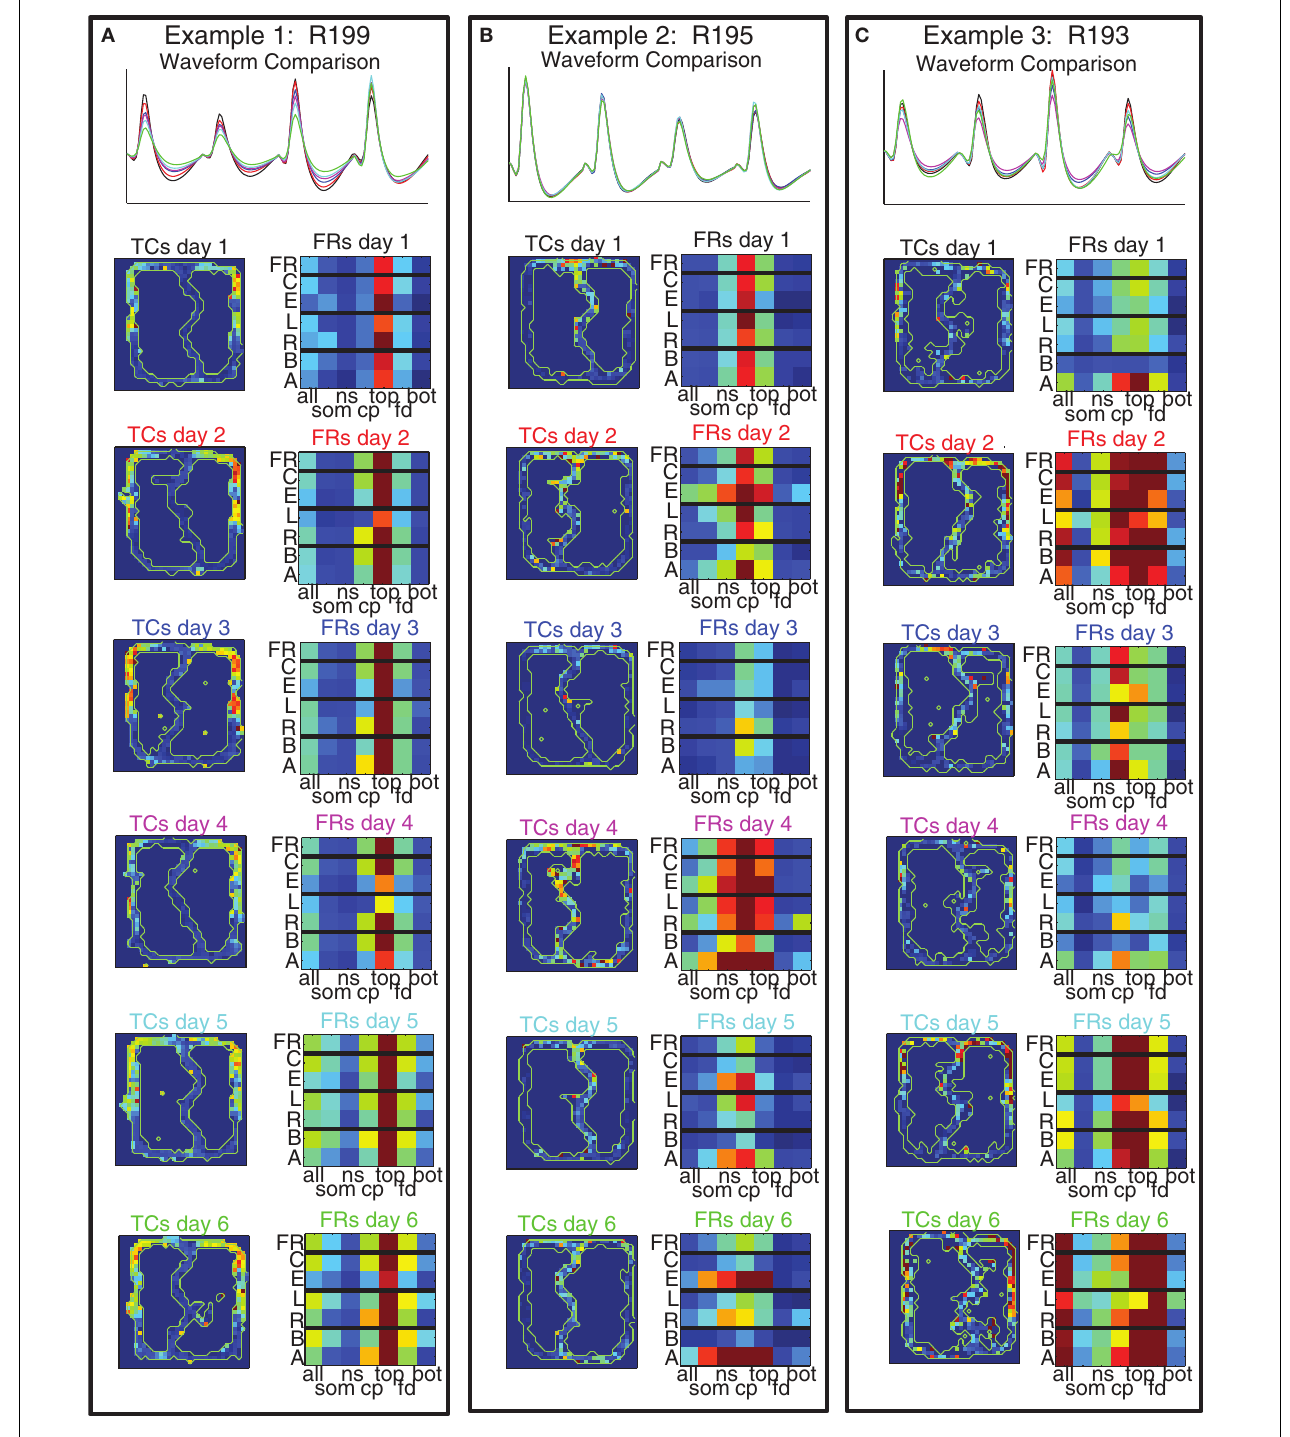
FIGURE 11 | Example cells with matched waveforms across all 6 days. For each cell we show: (Top) comparison of waveforms across all 6 days; (Left Column) Spatial tuning curves over the maze for all 6 days; (Right Column) 7 × 7 grid of cell firing. The 7 × 7 grids divide firing rate of the cell into bins dictated by maze location on the x axis (using the 7